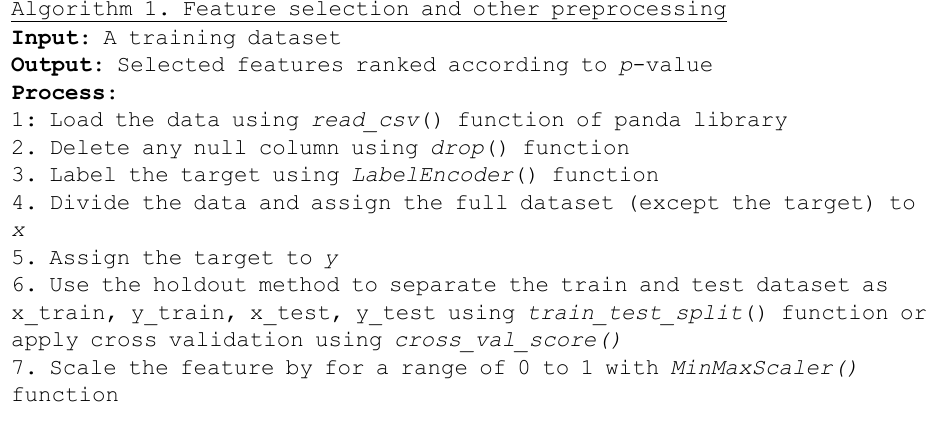
Algorithm 1. Feature selection and other